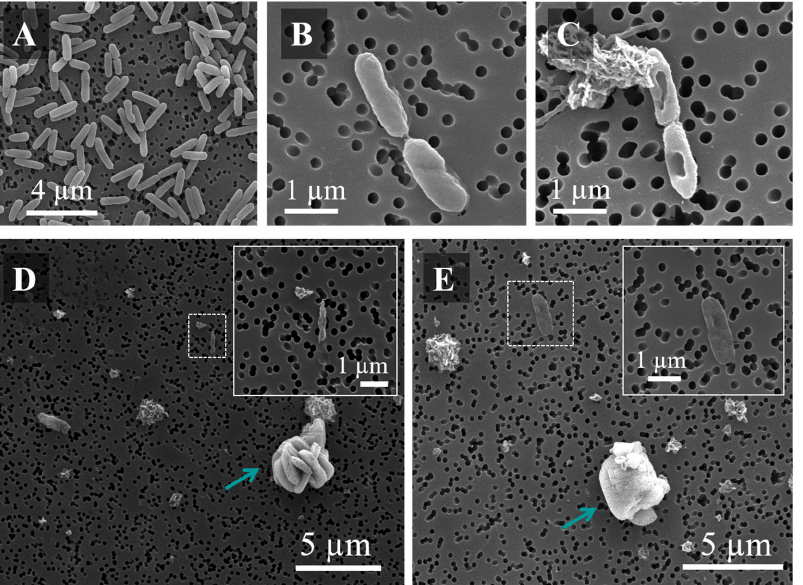
Figure 8. Images obtained by SEM of P. aeruginosa : ( A ) Control; ( B ) After treatment with raw colistin sulfate; ( C ) After treatment with ALG@CLS MPs; ( D , E ) In contact with ALG@CLS MPs (blue arrow) with dead bacteria in contact with CLS-loaded microparticles.